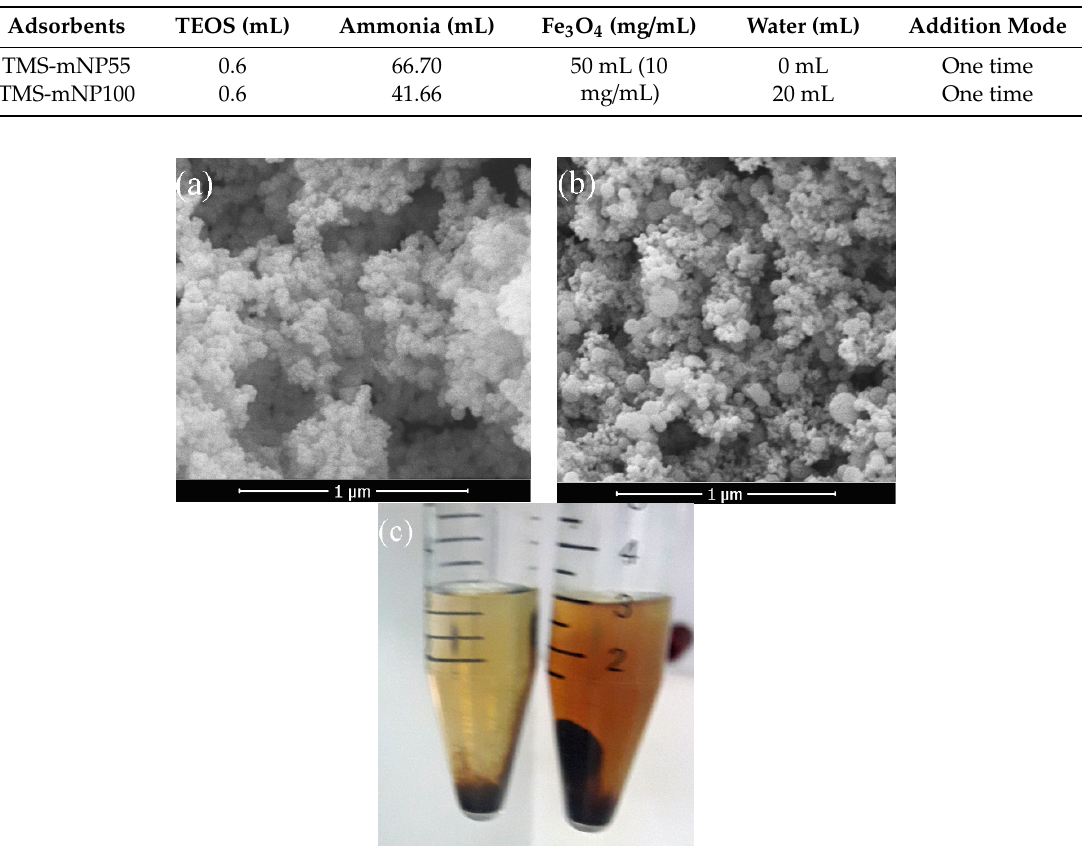
Figure 9. SEM micrographs for ( a ) trimethyl ethoxysilane (TMS)-mNP55 and ( b ) TMS-mNP100 while the photo in ( c ) shows the difference between magnetic decantation for both grafted mNPs (TMS-mNP55—Right and TMS-mNP100—Left).